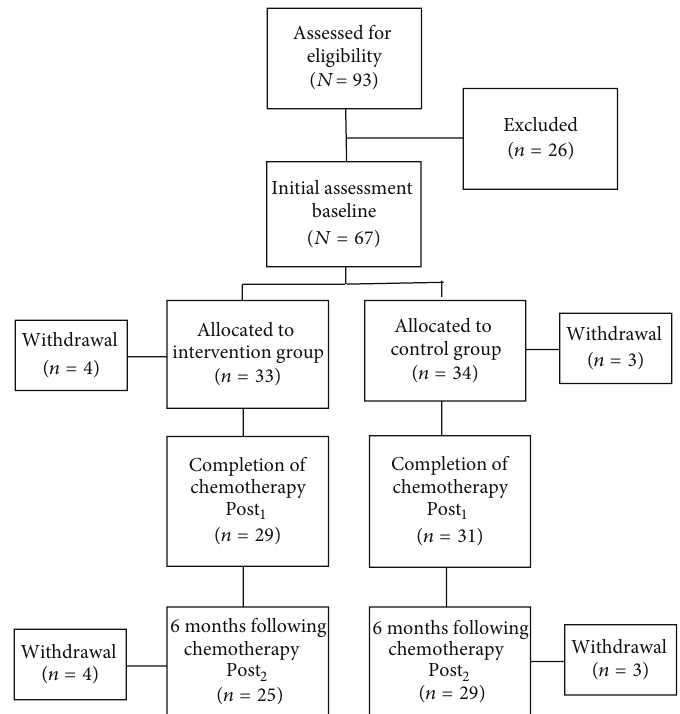
Figure 1: Flow of breast cancer patients through the